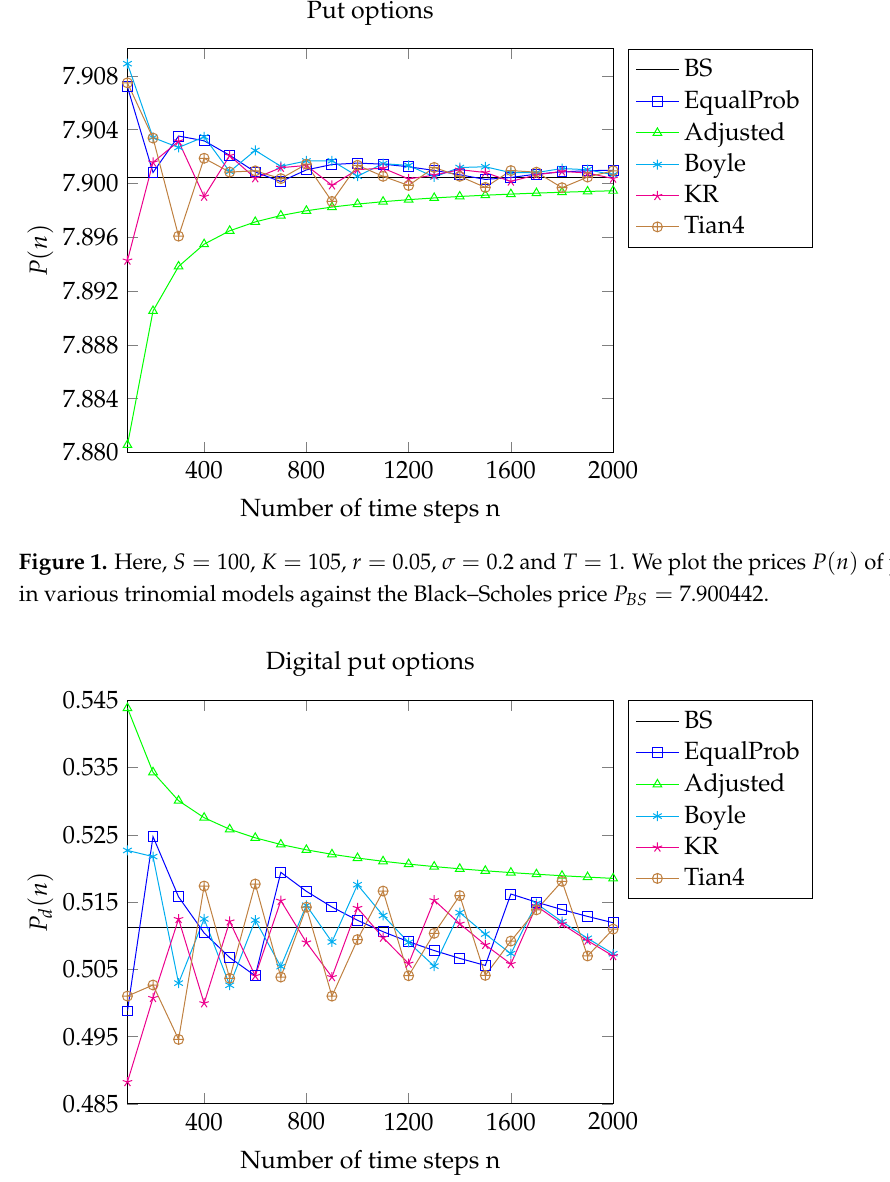
Figure 2. Here, S = 100, K = 105, r = 0.05, σ = 0.2 and T = 1. We plot the prices P d ( n ) of digital put options in various trinomial models against the Black–Scholes price P BS =